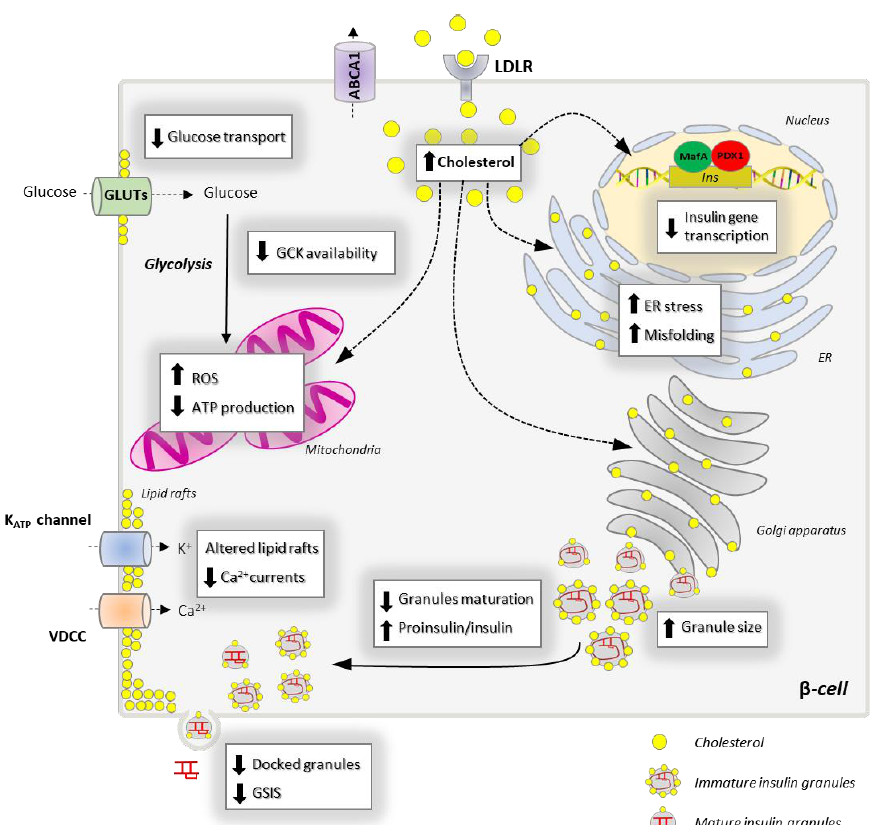
Figure 4. Impact of cholesterol overload on the insulin biosynthetic and secretive pathway. Increased cholesterol uptake via LDLR or reduced efflux through ABCA1 transporter leads to increased intracellular cholesterol, which strongly affects β -cell functionality through different mechanisms. Cholesterol accumulation downregulates the expression of PDX1 and MafA transcription factors reducing the transcription of the insulin gene. Cholesterol overload in the ER activates the UPR response leading to ER stress and proinsulin misfolding. Cholesterol also accumulates in the Golgi apparatus and in the membranes of insulin granules leading to their enlargement which, in turn, affects granules maturation (increased proinsulin/insulin ratio). Excessive cholesterol into the mi- tochondria induces the production of ROS, which impairs the mitochondrial membrane potential resulting in the reduction of ATP production. Cholesterol overload alters plasma membrane fluidity, (GLUTs) activity and levels at the plasma membrane, decreased glucokinase (GCK) availability and altered distribution of voltage-dependent Ca 2+ channels (VDCC) and K + ATP channels. As a